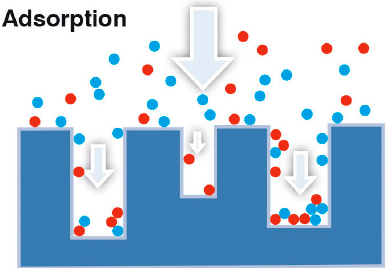
Figure 2. Adsorption of refrigerant over the external surface of an adsorbent solid material.